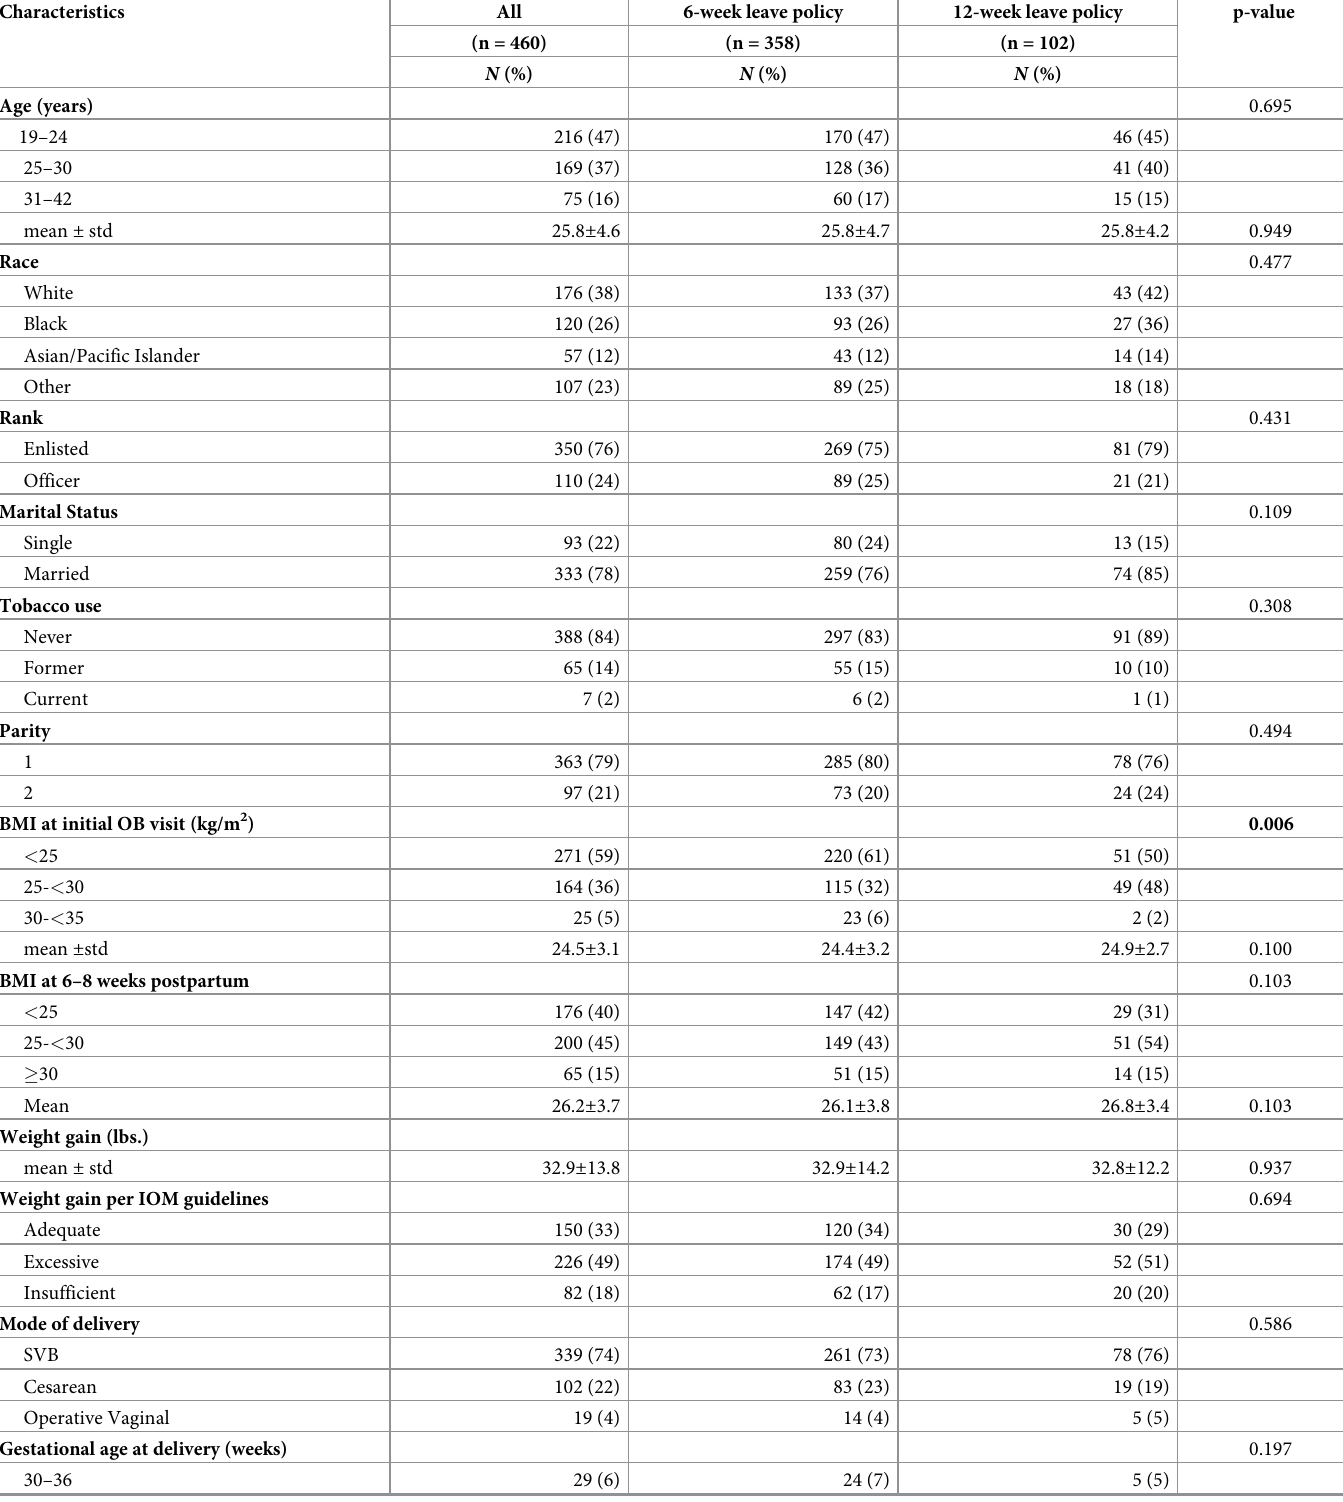
Table 1. Demographic and pregnancy characteristics.